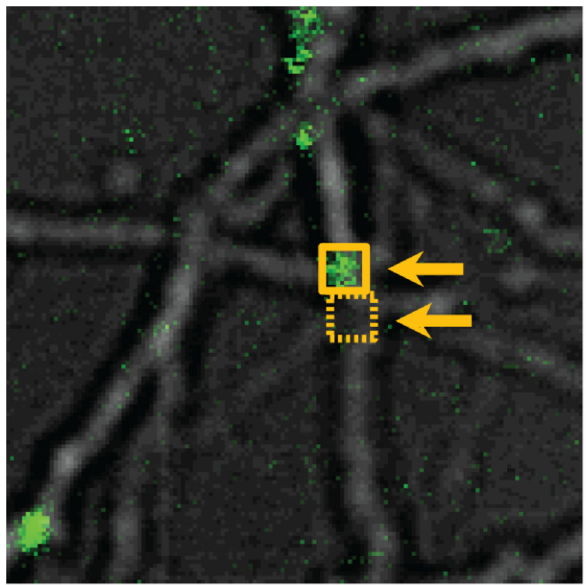
Aβ oligomer size is determined by